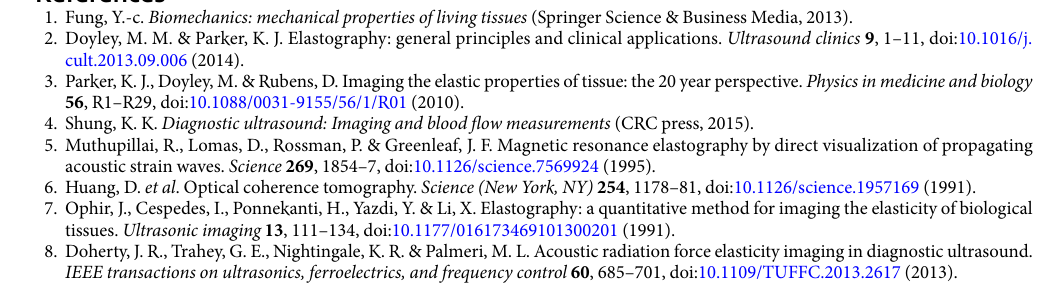
where E is the Young’s modulus, ρ is the tissue density, C s is the shear wave speed. By further assuming a fixed direction of propagation (perpendicular to excitation beam axis) and negligible dispersion issue, the SWS can be calculated from the TOF based approach 47, 48 . In TOF SWS reconstruction algorithm, the shear wave propagation timing at each lateral off-axis position outside the ROE is indicated by shear wave’s peak displacement. Giving a lateral propagation distance ( Δ x ), TOF SWS can be calculated by overall propagation time (two detection posi- tions) approach using = ∆ or multiple arrival time (multiple detection positions) approach using linear C s x ∆ t regression algorithm. Compared with only one detection position of ARFI, the data acquisition time of SWEI is significant longer. Multiple arrival time approach is typically implemented in an array system to image a large region. To get a fine spatial resolution and speed up the data acquisition speed, overall propagation time approach was implemented in this study for SWEI. As indicated at the beginning, the purpose of our imaging system is to characterize small scale soft tissues with expected Young’s modulus in the range 0.1–100 kPa. By assuming a con- stant density of soft tissue, typically 1000 kg/m 3 , the maximum SWS is 5.8 m/s in SWEI. Time interval of TTP displacement profile should be at least 50 µ s limited by PRF; therefore, the minimum off-axis distance is 290 µ m. In order to satisfy the requirement that the region in which the shear wave propagates is homogeneous and to sustain a high resolution, a small propagation distance is preferred. However, the propagation distance is better to be larger than the beamwidth of the excitation transducer 49 . Thus, a 350 µ m laterally off-axis distance ( Δ x ) was used to quantify the SWS with a good balance between precision and resolution.